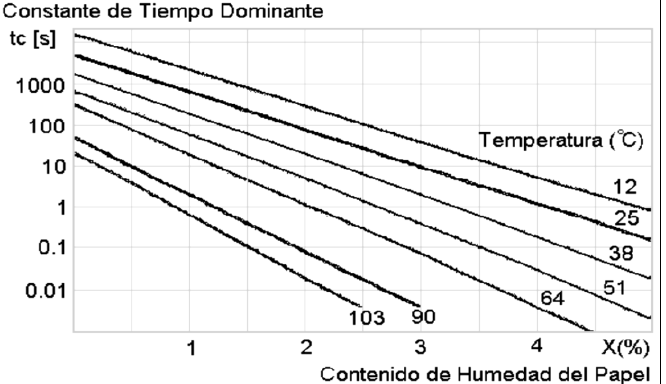
Figura 6: Estimación del contenido de humedad. Fuente: Autores, (2017).